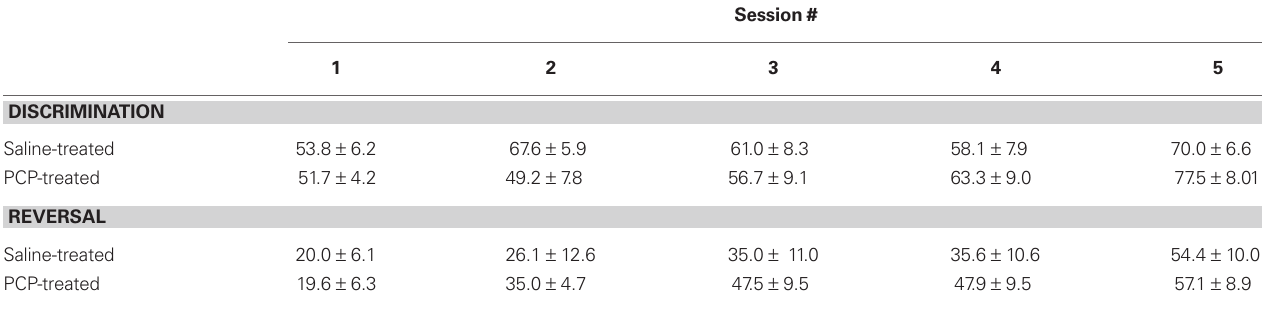
Table 2 | Effects of subchronic PCP treatment on performance during early discrimination learning and reversal. PCP treatment has no signifi cant effect on percent correct performance during the fi rst fi ve sessions of either discrimination learning or reversal. Data are means ± SEM percent